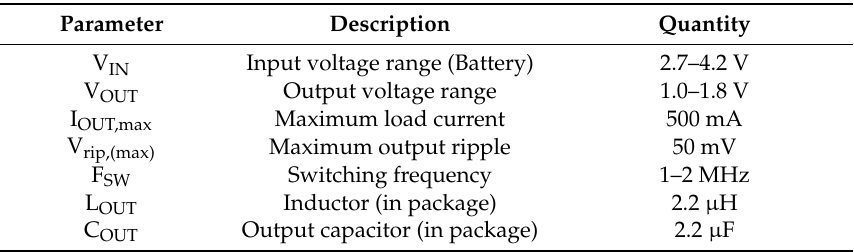
Table 1. Designed buck converter specifications.